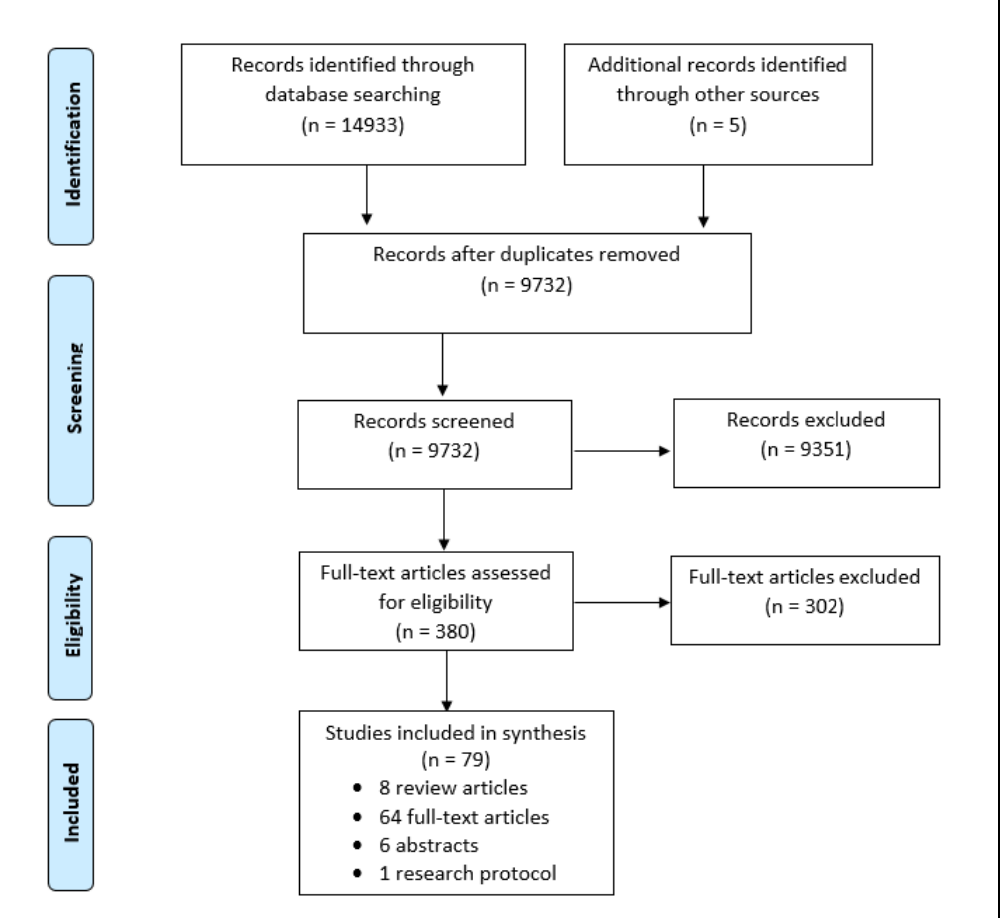
Figure 1. Prisma Flow Diagram.